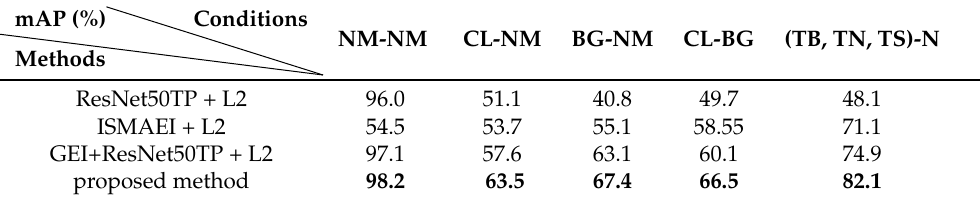
Table 4. Comparison among the different modules of the proposed method and the proposed method on the testing set. mAP (%) is